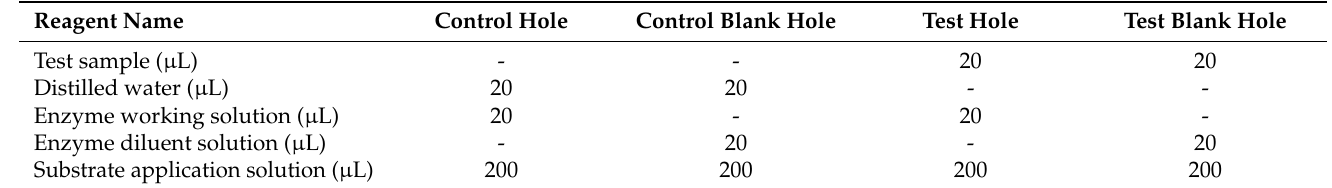
Table 4. Operation